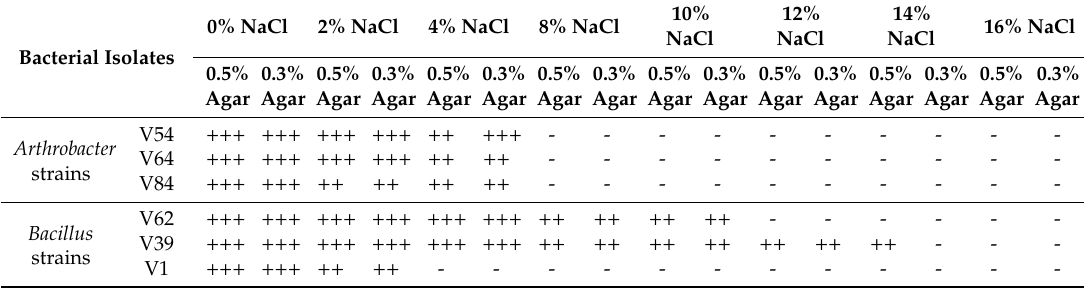
Table 2. Swarming (0.5% agar) and swimming (0.3% agar) abilities of bacterial strains at di ff erent concentrations of